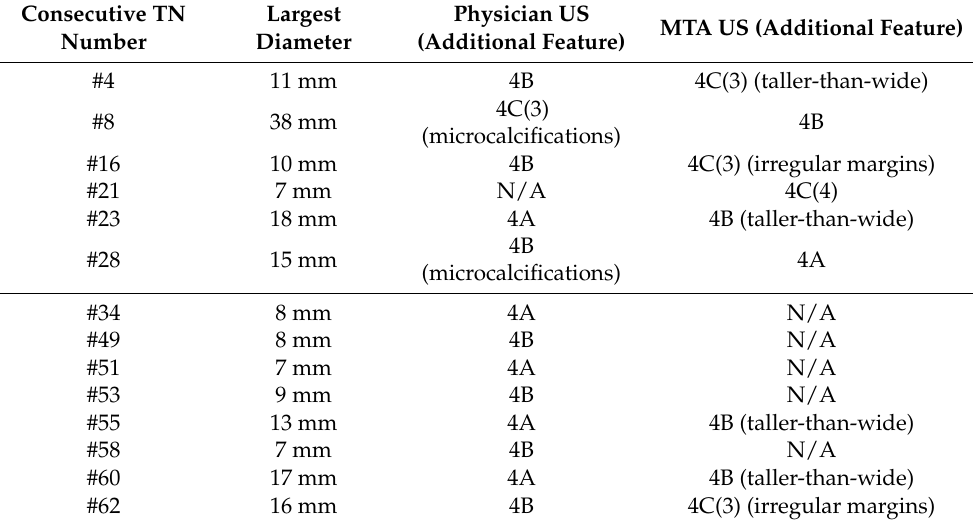
Table 3. List of thyroid nodules (TN) that were rated differently on conventional physician US